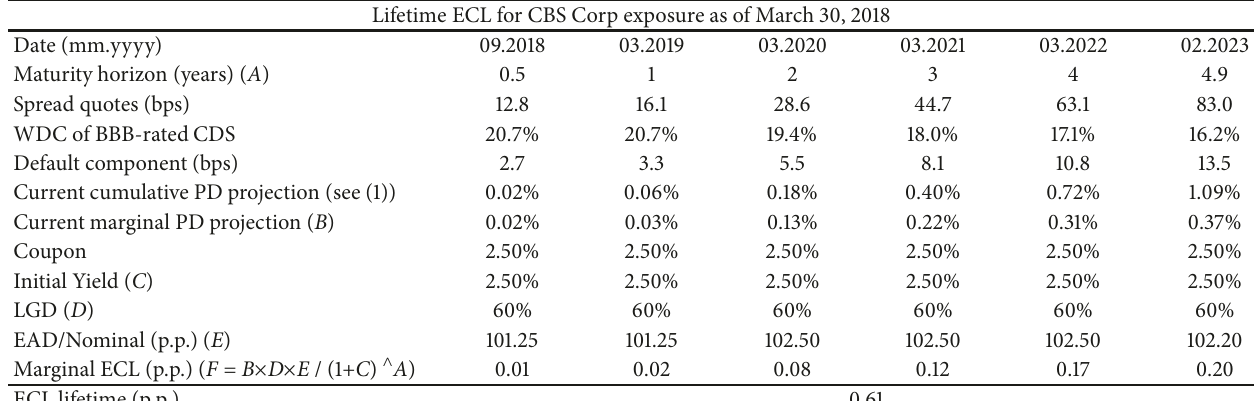
Table 2: Lifetime ECL for the bond of CBS Corp as of March 30, 2018.